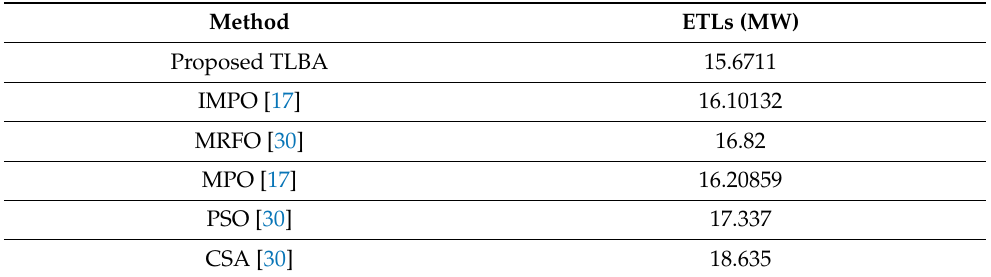
Table 10. Comparative results for the minimization of the ETL S of the IEEE 57-bus